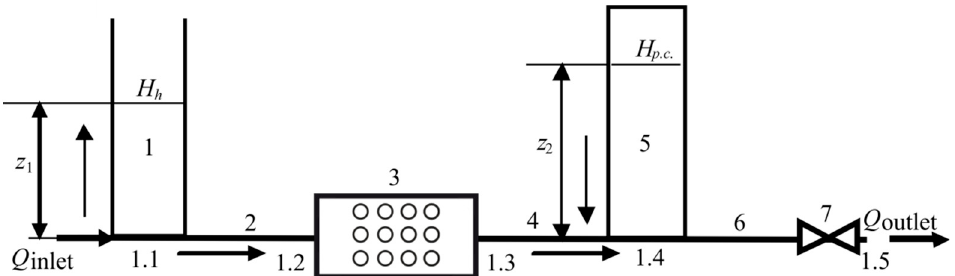
Figure 3. A scheme of the hydraulic model to generate a pulsating flow: 1—hydraulic accumulator, 2, 4, 6—pipes, 3—tube bundle, 5—pulsation chamber, 7—valve.